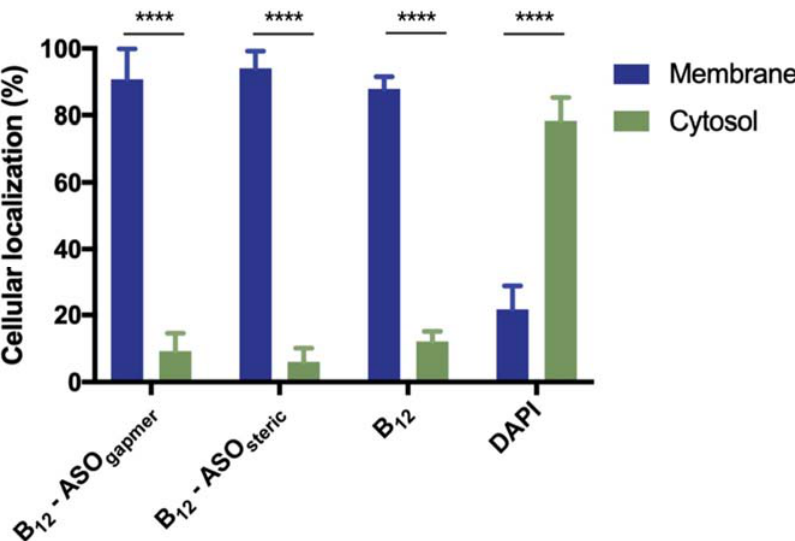
Figure 5. Cellular localization of B 12 conjugates, B 12, and DAPI control in E. coli K12. B 12 conjugates and B 12 are mainly found on the OM, while the DAPI control is mostly associated with the cytosol. No significant differences were observed between the different internalized conjugates and between the conjugates and the B 12 control ( p > 0.05). Significant differences were observed between the membrane and cytosol-associated compounds ( p ≤ 0.0001, ****). The fluorescence of each fraction present in the DAPI control is significantly different from the tested counterparts ( p ≤ 0.0001). Results are presented as mean values and respective standard deviation from three independent assays (using duplicates in each).